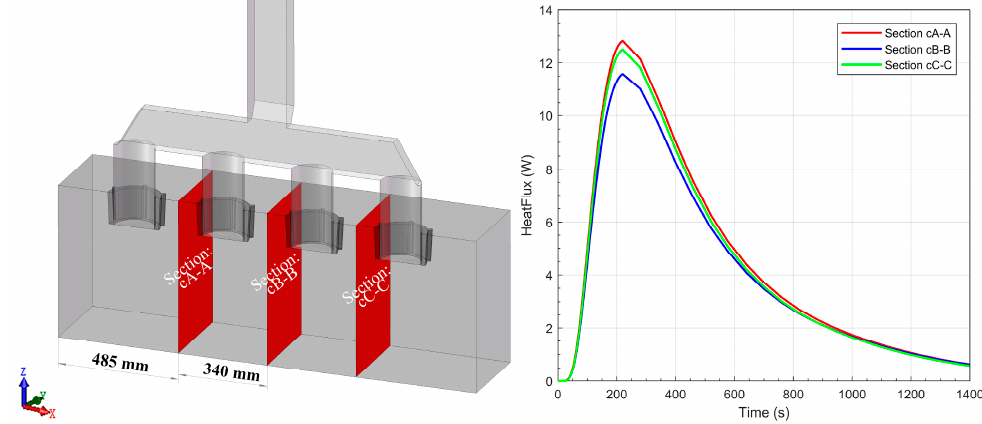
Figure 11. The heat transfer rate between the adjacent stub holes.